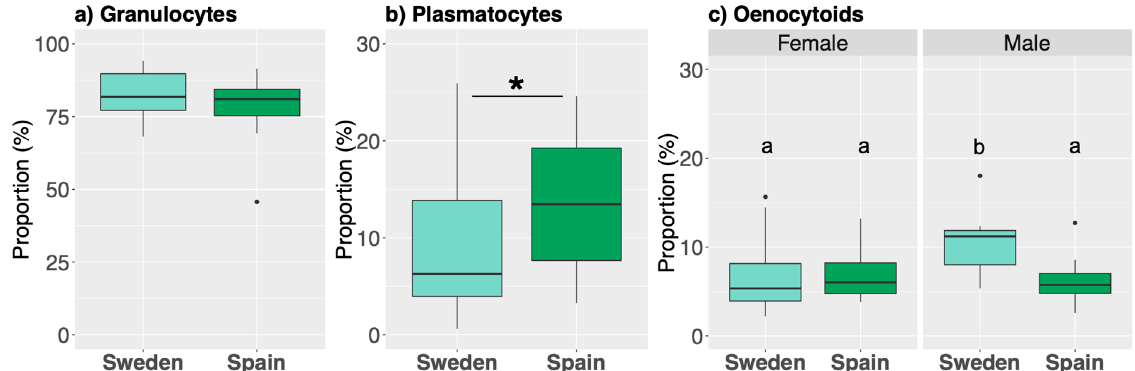
Figure 3. The overall cell composition of the total number of hemocytes during the phagocytosis assay as measured via imaging ( N = 44 larvae). The most abundant cell types are granulocytes, followed by plasmatocytes and oenocytoids (panels a , b , and c respectively). Populations were only different for plasmatocye proportions, while only males from Sweden had a significantly higher proportion of oenocytoids. Within each bar plot, colored boxes contain X of the data, with whiskers representing the largest and smallest values within 1.5* interquartile range. The bar with asterisks (*: p ≤ 0.05) in panel b represents a significant difference between populations, while the letters above each bar plot in panel C denote significance relationships among these four samples of oenocytoids.